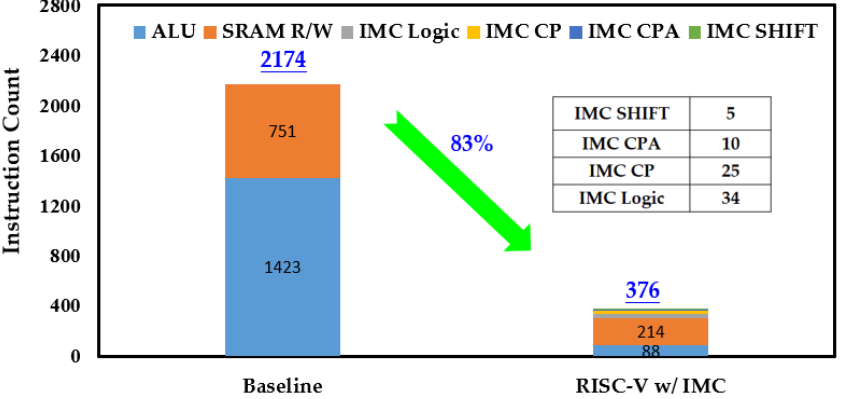
Figure 9. Comparison of instruction count in one round of Keccak- f permutation.